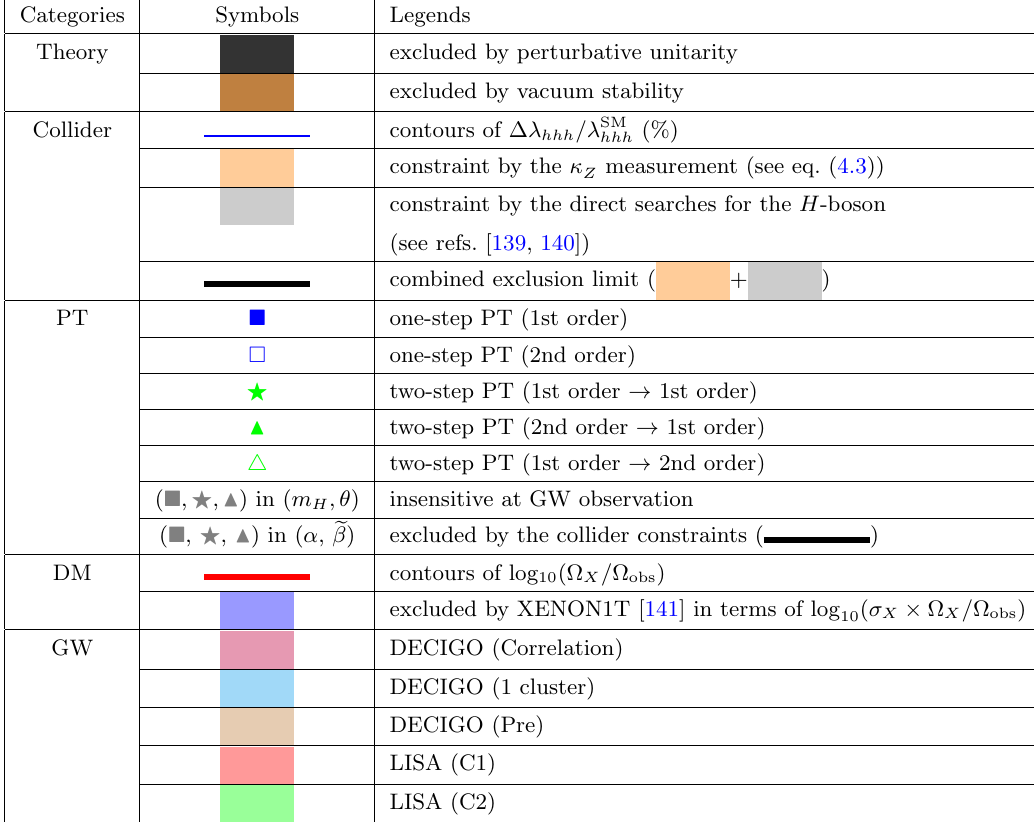
Table 1 . Figure legends for figures 3–9.